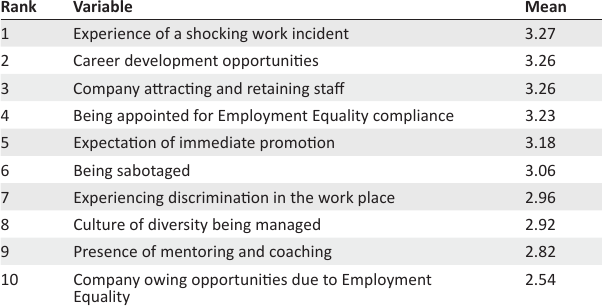
TABLE 11: The least important variables that drive